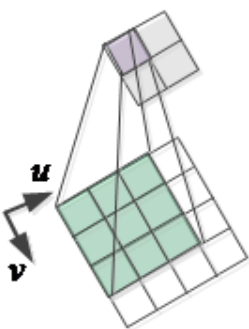
Figure 3. Dimensions of the input are 4 × 4 × 1, and dimensions of the convolution kernel are 3 × 3 × 1; therefore, the output characteristic graph is 2 × 2 × 1.